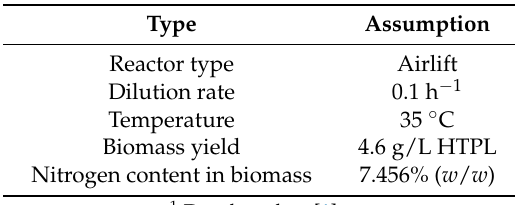
Table 1. Technical values used for the Fungus Scenario 1